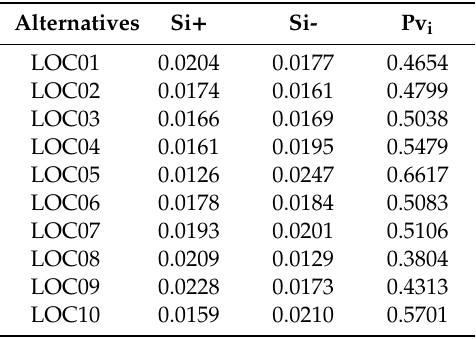
Table 5. Results from TOPSIS